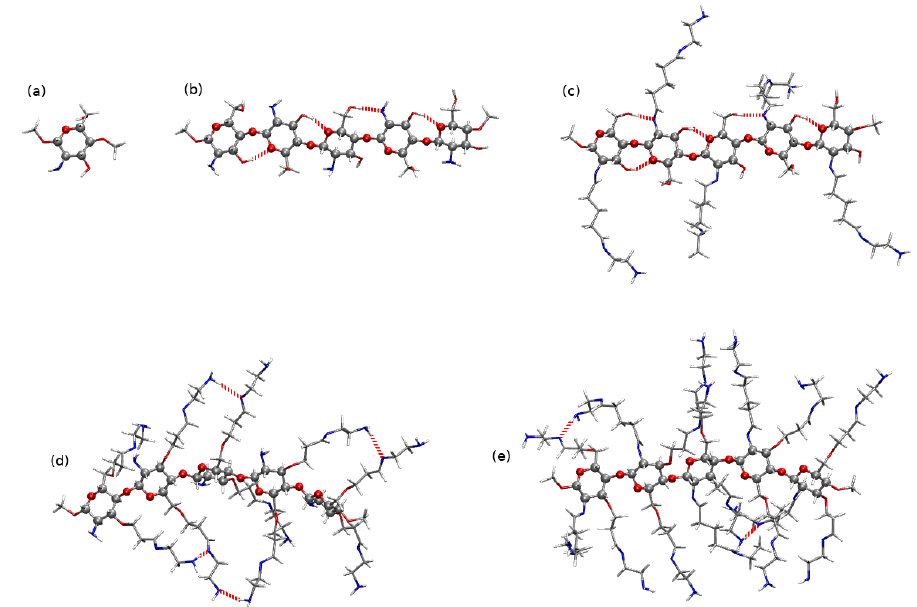
Figure 9. Investigated models of chitosan: ( a ) pristine single chitosan unit CS1, ( b ) pristine five-units chain fragment CS5 and substituted five-units chain fragments: ( c ) single –NH 2 -substituted CS5(NH 2 ), ( d ) double –OH-substituted CS5(NH 2 ) 2 and ( e ) all three functional groups-substituted CS5(NH 2 ) 3 . Ball representation used for atoms in the main chain and licorice for side chains. Atom colors: red—oxygen, blue—nitrogen, silver—carbon, white—hydrogen. Red dashed lines sketch intramolecular hydrogen bonds according to the following criteria: distance between the hydrogen bond donor and hydrogen bond acceptor equal to 3.5 Å and the angle H–donor–acceptor 30 ◦